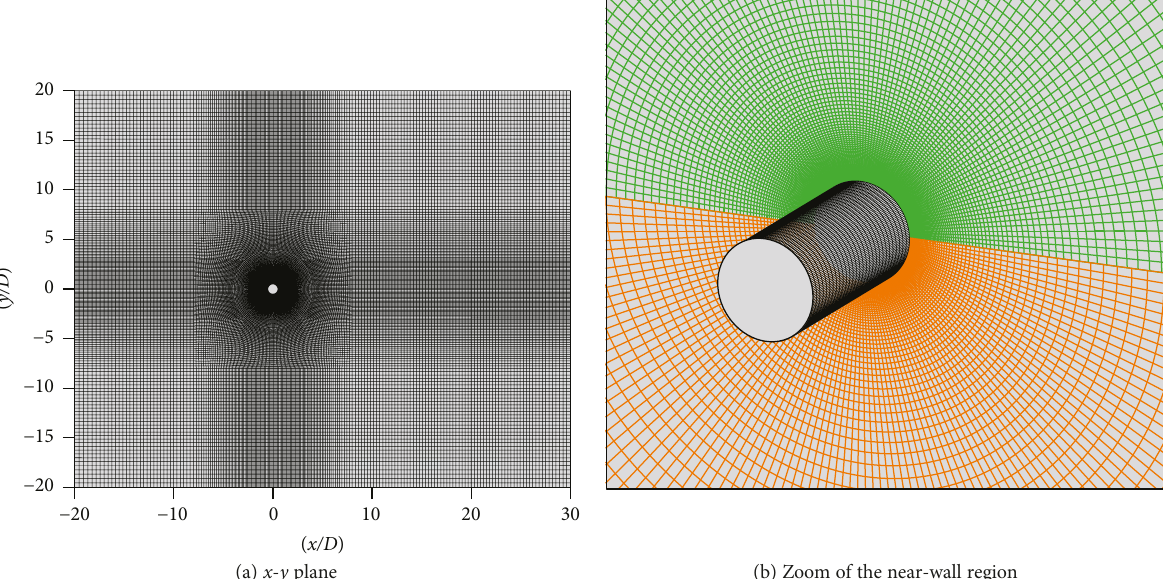
Figure 2: The design of cross-sectional grid (a) overview and (b) near-wall region (top, fi ne grid; bottom, coarse grid).